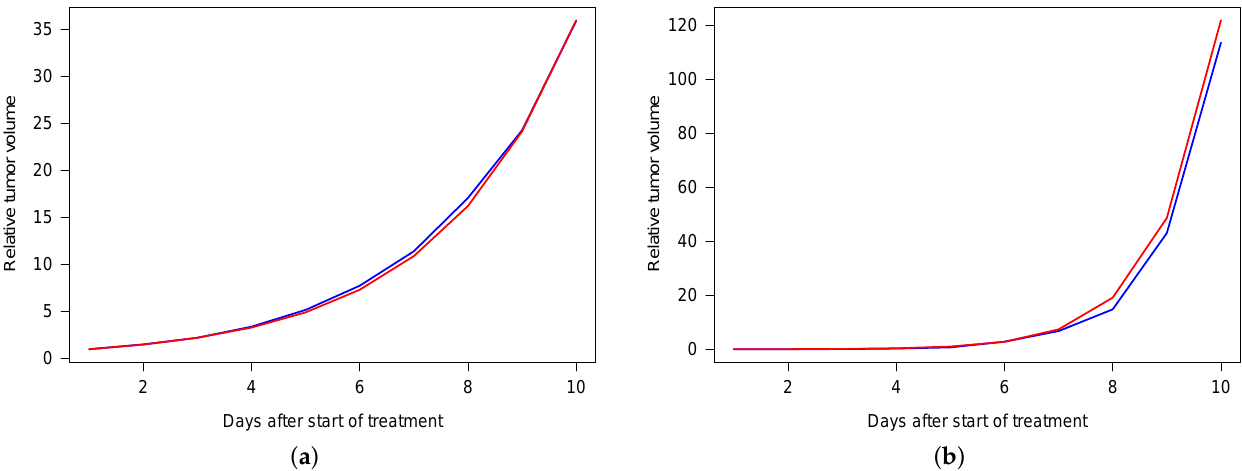
Figure 4. Mean ( a ) and variance ( b ) of simulated sample paths (in blue) and the fitted model (in red) for σ = 0.1.